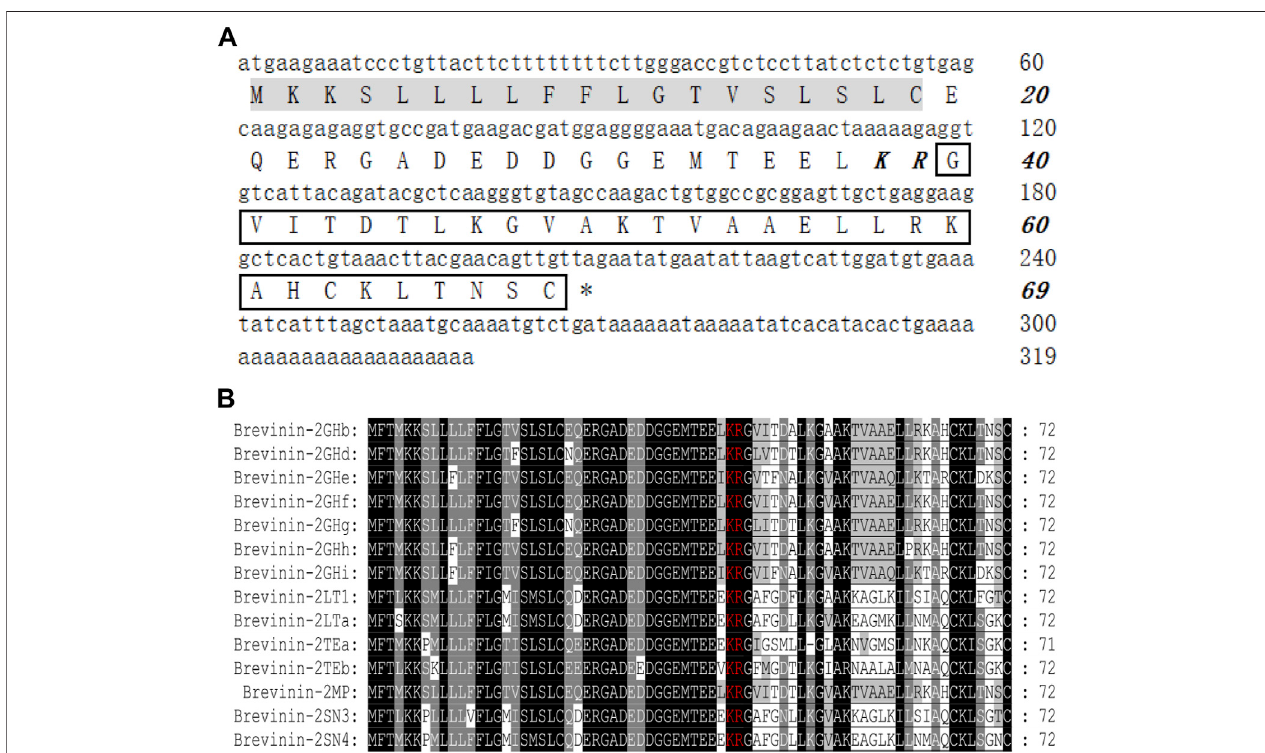
FIGURE 1 | Sequence characterization of brevinin-2MP. (A) The cDNA and deduced amino acid sequences of brevinin-2MP. The signal peptide is marked with a gray background, and the KR residues in italic bold type indicate the end of an acidic spacer domain. The sequence of mature peptide is boxed, and the stop codon is denotedbyanasterisk(*). (B) Multi-sequencealignmentofthebrevinin-2precursorsfromfrogs.TheKRresiduesattheendoftheacidspacerdomainaremarkedinred, and the same amino acid residues are represented with a black